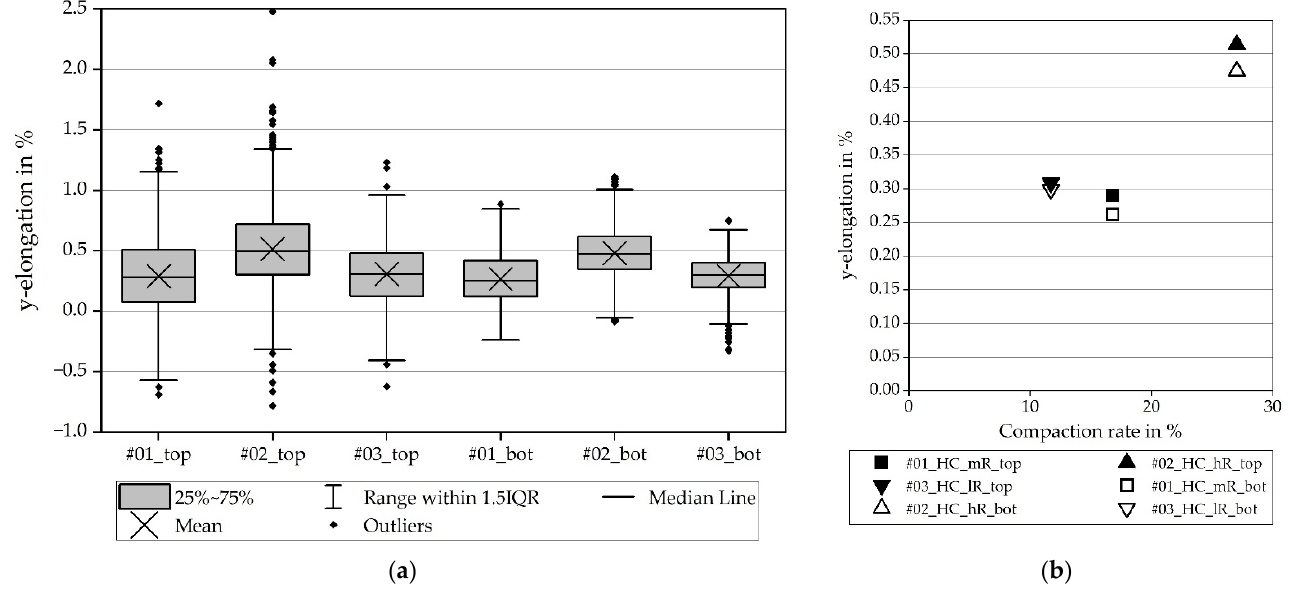
Figure 13 . Elongation in y-direction for the hard carbon anode, coating (_top) and current collector foil (_bot): ( a ) elonga- Figure 13. Elongation in y-direction for the hard carbon anode, coating ( _top) and current collector foil (_bot): ( a ) elongation tion with scatter ( b ) average values . with scatter ( b ) average